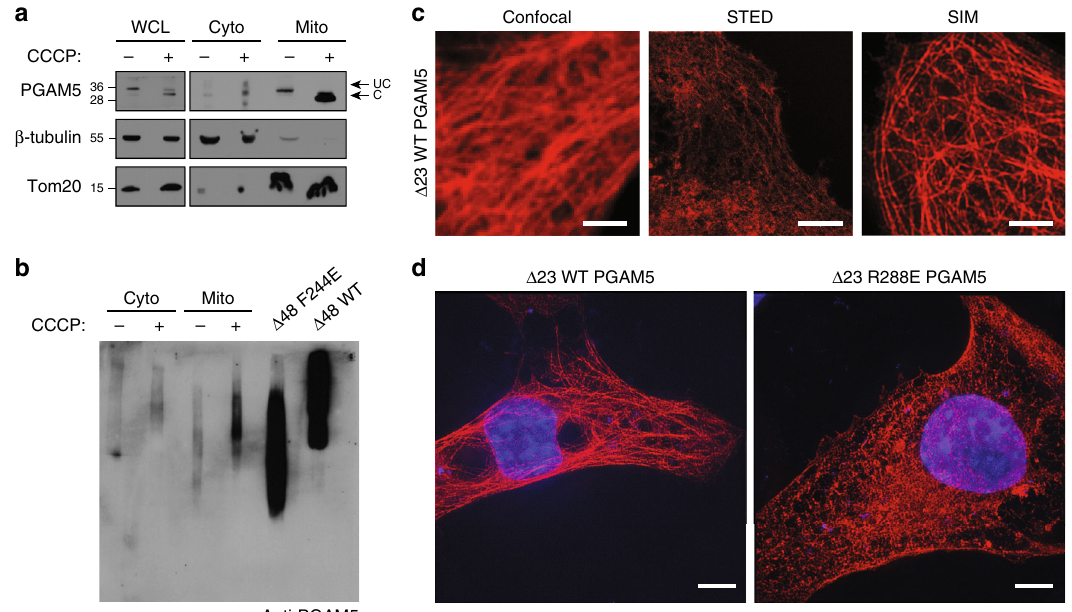
Fig. 6 Cleaved PGAM5 forms oligomers in cells. a SDS-PAGE analysis of endogenous PGAM5 in HEK293T whole cell lysate (WCL), mitochondrial (mito), and cytoplasmic (cyto) fractions 4 h post-CCCP treatment. Uncleaved (UC) and cleaved (C) PGAM5 bands are marked by arrows. b BN-PAGE analysis of endogenous PGAM5 4 h post-CCCP treatment in mitochondrial (mito) and cytoplasmic (cyto) fractions. Fractionation samples were normalized based on the total protein concentrations determined for the WCL samples. As a reference for migration behavior of PGAM5 oligomers, recombinant Δ 48 WT ( Δ 48 WT) and the oligomerization-de fi cient mutant Δ 48 F244E mutant ( Δ 48 F244E) PGAM5 were run alongside cellular fractionation samples on a 4 – 16% native-PAGE acrylamide gel (Invitrogen). Following electrophoresis, gels were immunoblotted with anti-PGAM5 antibody. c Comparison of myc-tagged Δ 23 PGAM5 fi laments in transiently transfected COS7 cells stained with anti-myc antibody using three different imaging methods: confocal microscopy (left panel), stimulated emission depletion (STED) microscopy (middle panel), and structured illumination microscopy (SIM) (right panel). All scale bars correspond to 5 µ m. d SIM images of myc-tagged Δ 23 PGAM5 fi laments in COS7 cells transiently expressing wild type (WT) or the R288E PGAM5 (red). Nuclei were stained using DAPI (blue). Both scale bars in d correspond to 10 µ